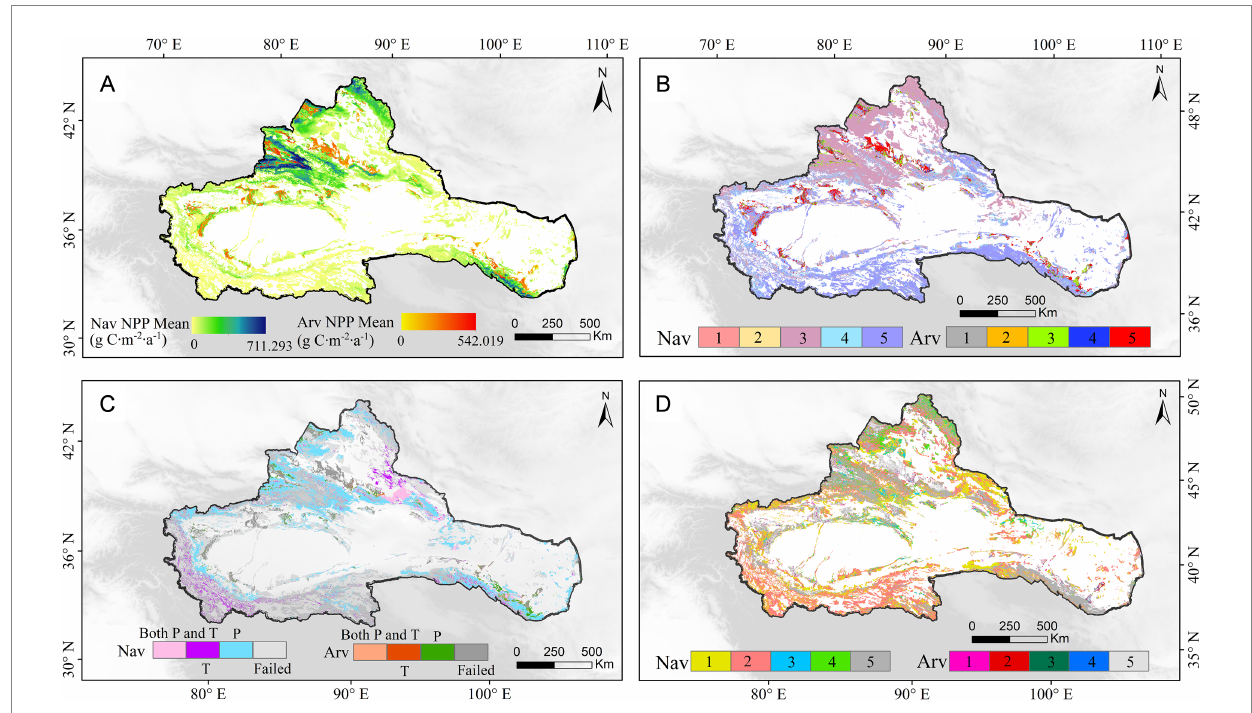
FIGURE 4 Net primary productivity (NPP) of vegetation in the NAR from 2001 to 2018: ( A ) period-mean NPP; ( B ) long-term trend of NPP (1. Extremely significant decrease, 2. Significant decrease, 3. No significant change, 4. Significant rise, 5. Extremely significant rise); ( C ) primary factors regulating interannual variations of NPP; ( D ) future variation trend of NPP (1. Sustained improvement, 2. Improvement to degradation, 3. Degradation to improvement, 4. Sustained degradation, 5. Insignificant).